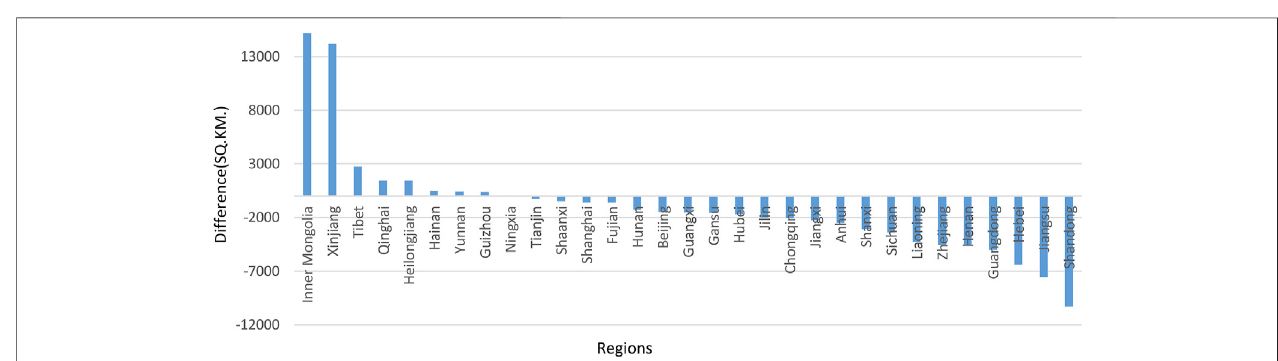
FIGURE 4 | The difference of cultivated land area of 31 regions in China during 2010 –